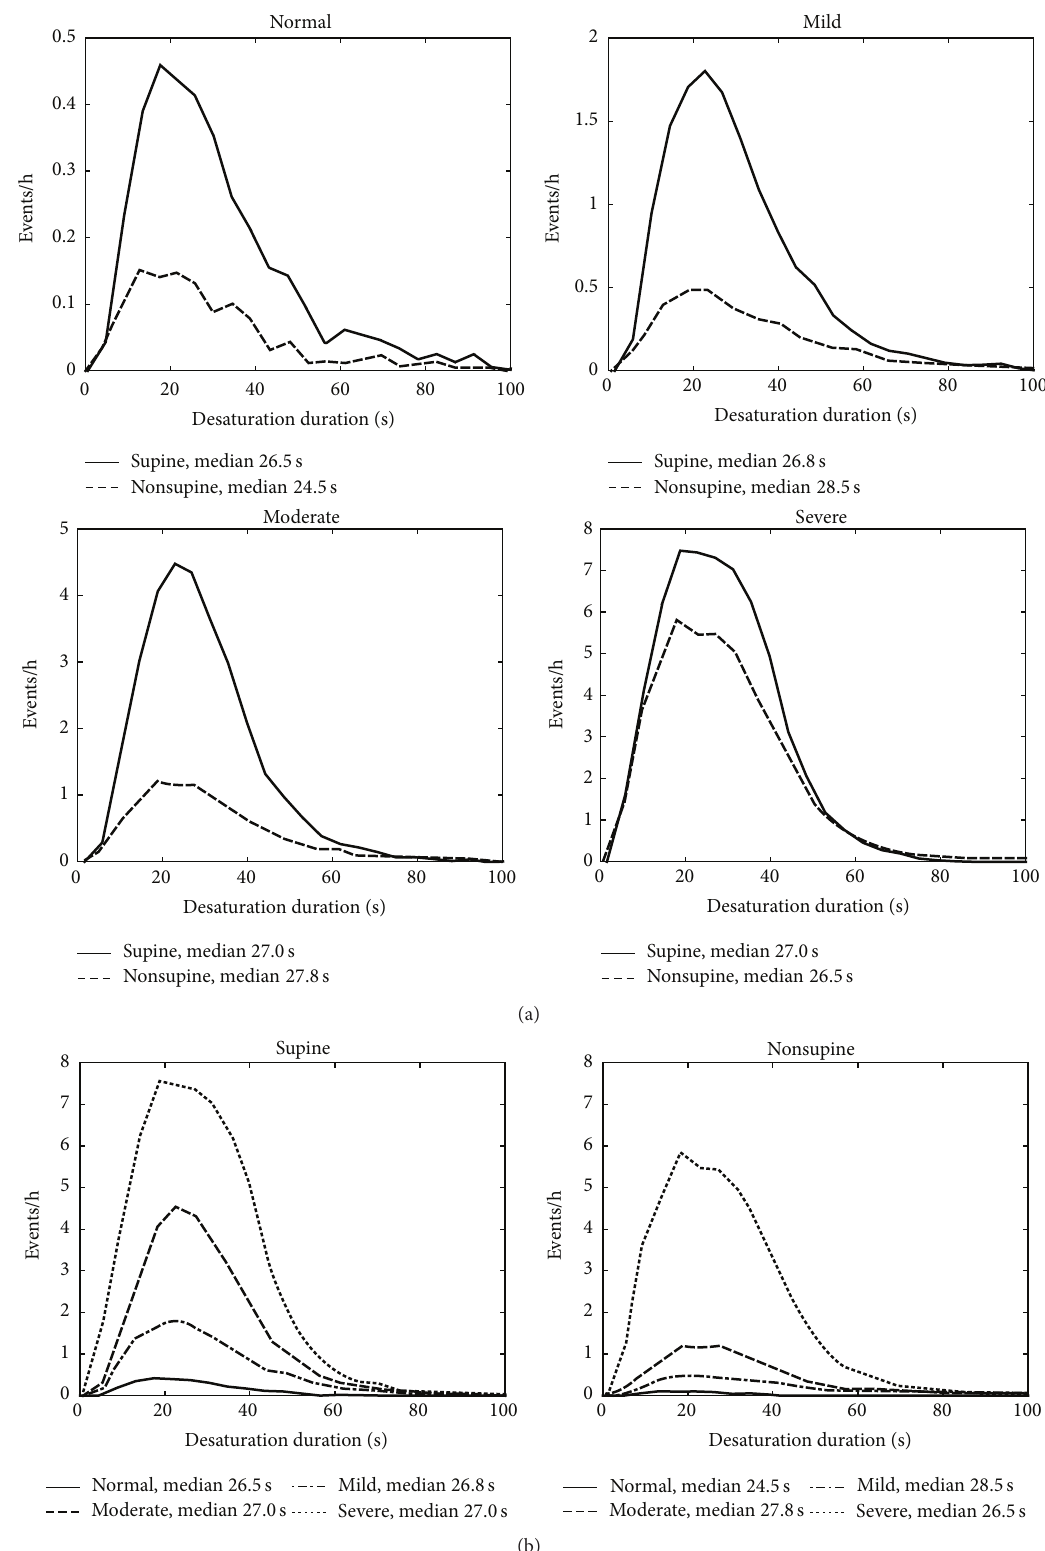
Figure 5: (a) Positional sleeping time adjusted distributions of the durations of individual desaturation events in supine and nonsupine positions in different OSA severity categories and (b) distributions in nonsupine and supine positions as a function of OSA severity. In mild and moderate OSA categories the median durations of the desaturation events are longer in nonsupine position than in supine position. The differences in the distributions of desaturation event durations are statistically significant in all OSA severity categories based on mixed model